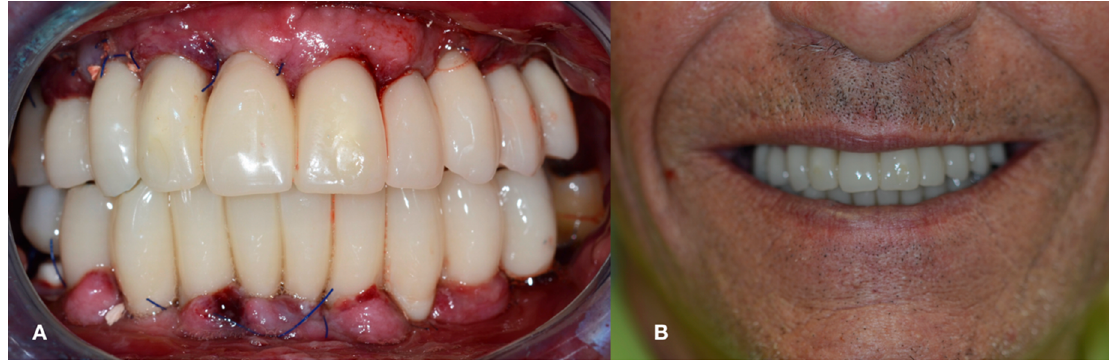
Figure 11. Immediate loading of interim fixed prosthesis. ( A ) Interim immediate restoration. ( B ) Extraoral view.